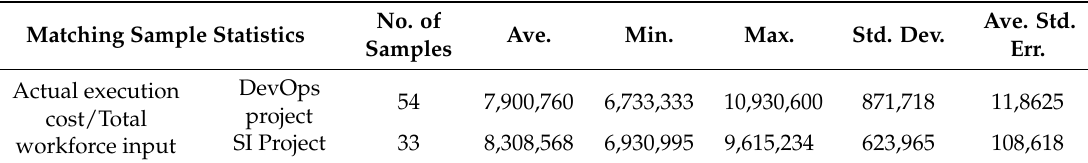
Table 13. Matching sample statistics of workforce input—actual execution cost.